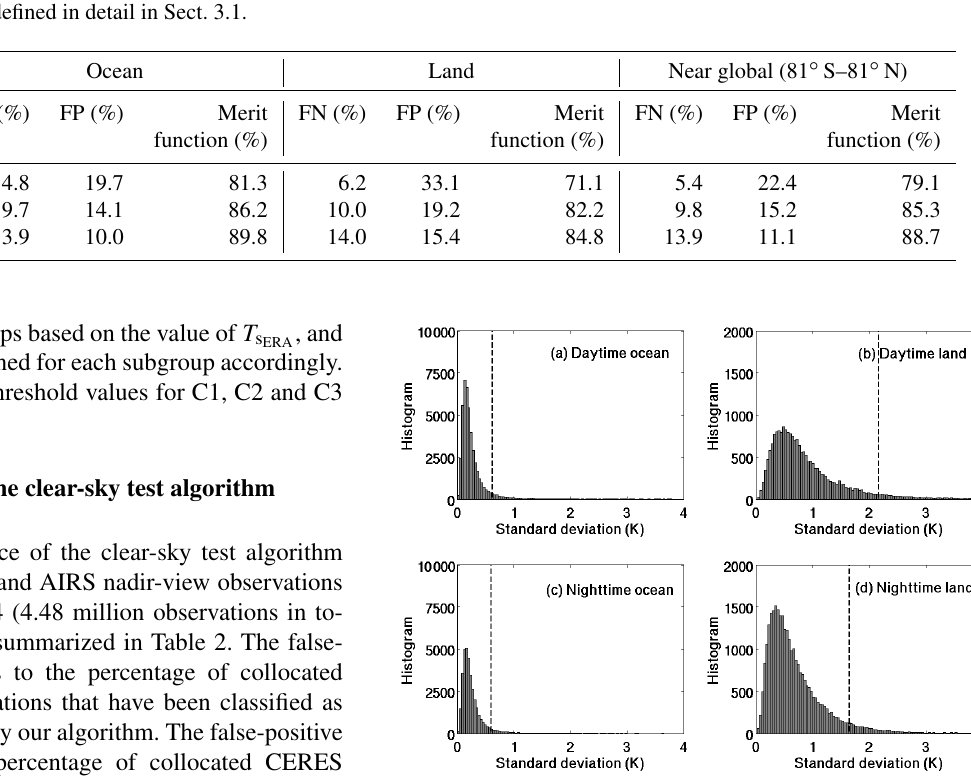
Figure 1. Histogram of the standard deviations of 963.8cm − 1 brightness temperatures for an AIRS clear-sky footprint and four adjacent AIRS footprints. The clear-sky information from collo- cated CERES observation is used. The histograms for daytime ocean, daytime land, nighttime ocean and nighttime land are plot- ted separately. One hundred bins are used in each panel. The black dashed line denotes the 95% percentile and corresponds to the value of C1 shown in Table